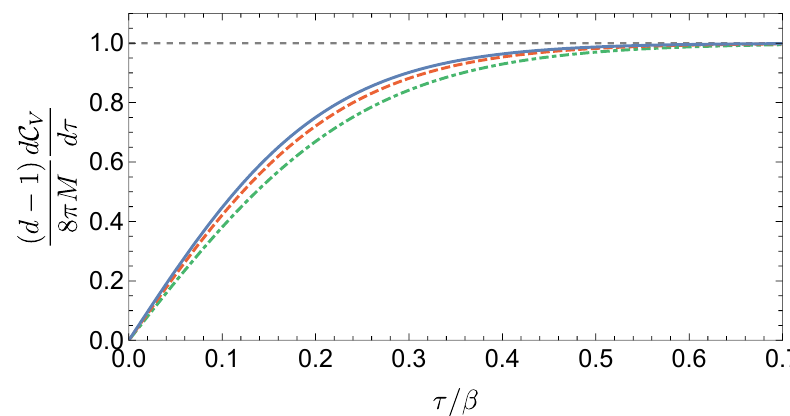
d C V Figure 7 . Plot of d (cid:0) 1 for planar d = 4 (blue), planar d = 3 (dashed-red) and d = 2 (dot-dashed 8 (cid:25)M d(cid:28) green) black holes. All three curves are independent of r h =L and approach to one at late